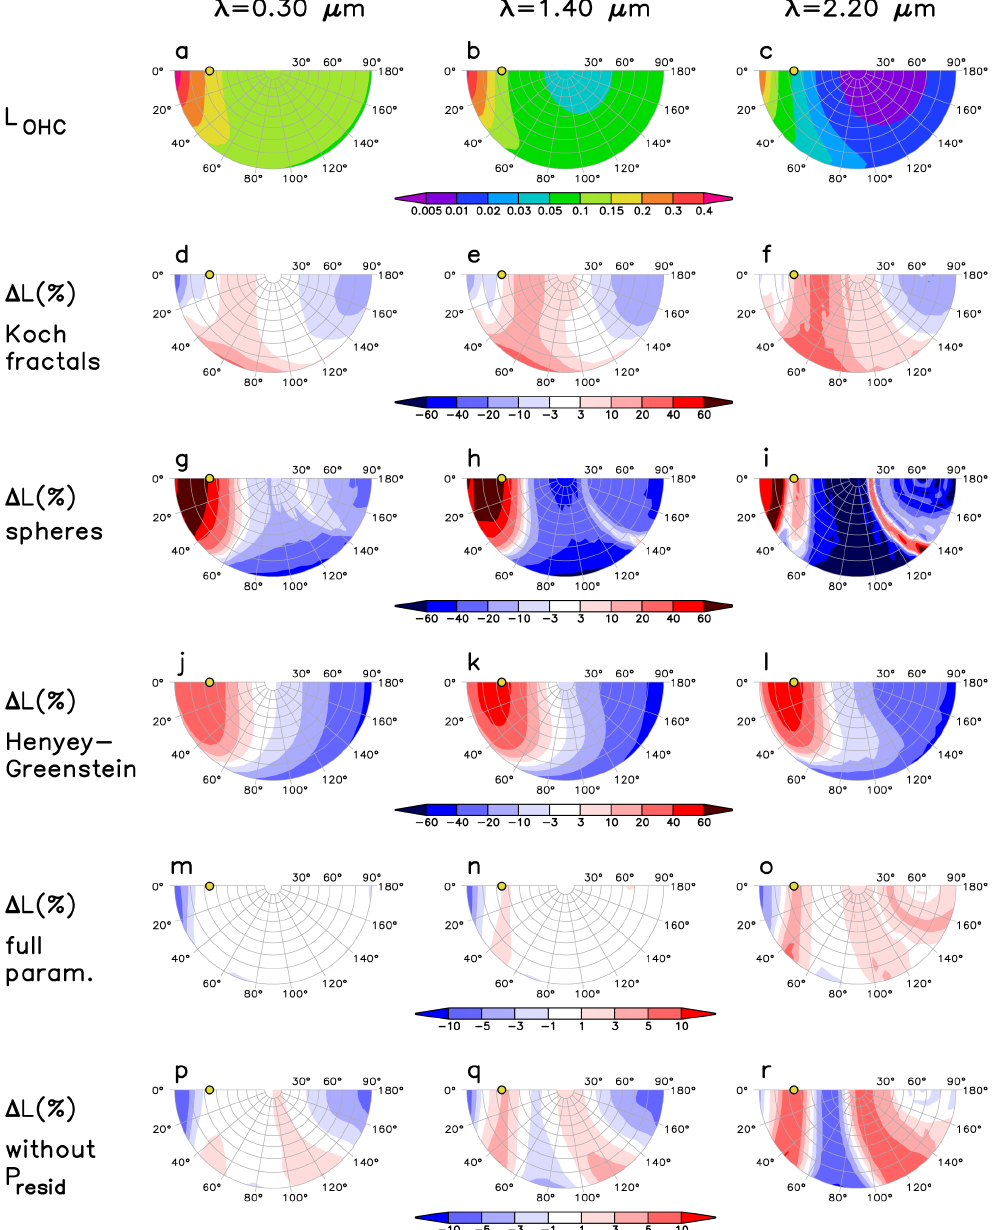
Figure 14. As Fig. 13 but for three wavelengths λ = 0.30, 1.40 and 2.20µm for a single value of the cosine of zenith angle for incident radiation µ 0 = 0.4 and a single particle size r vp =